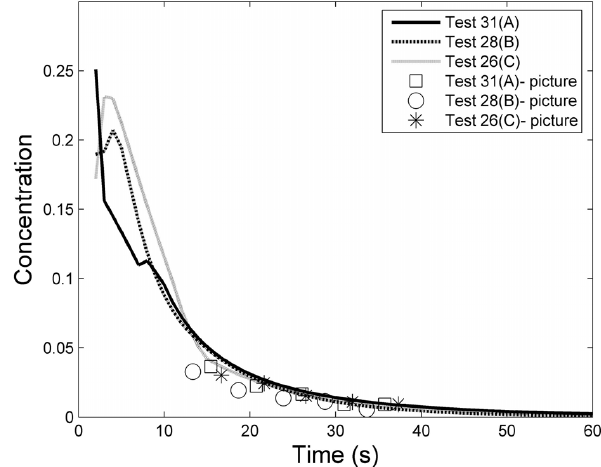
Fig. 9. Mean sediment concentration in time (measures from load cell and probe and from pictures analysis), related to the last em- bankment section s L . Fig. 7. Water discharge, Q w , (measured by level and probe) and sediment discharge, Q s , (measured by load cell and deduced by pictures), for three different embankment compositions (A, B, C).